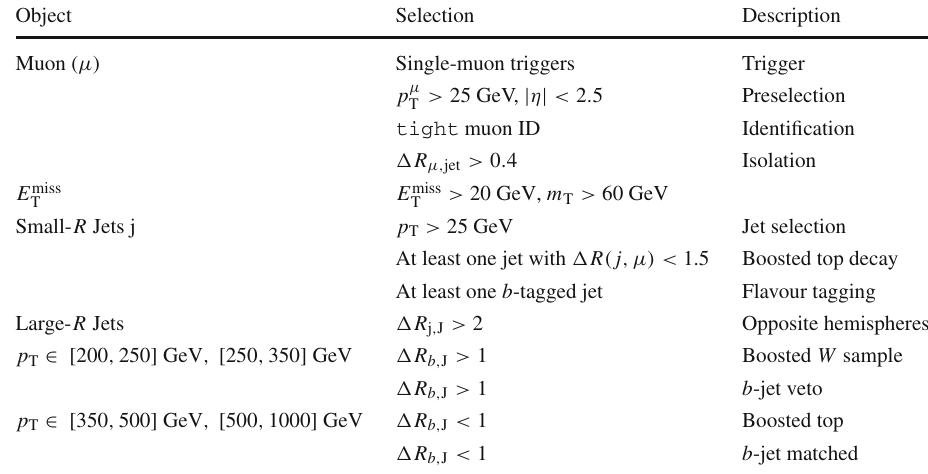
Table 5 Summary of the event selection for the top quark events decaying into lepton+jets, to be used for top and W mass calibration. The p T bins into which events are divided are also